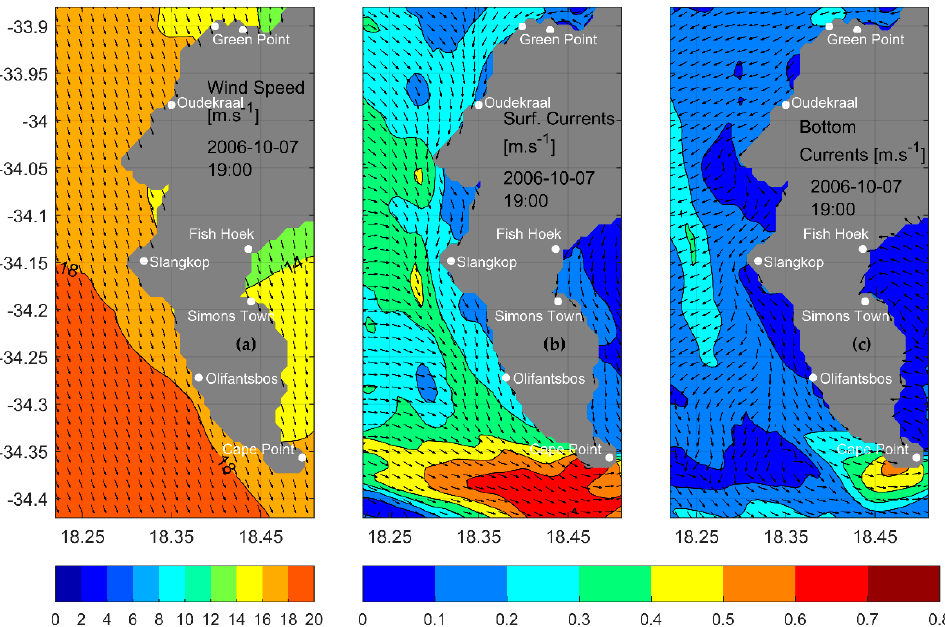
Figure 11. Near-surface ( b ) and bottom flows ( c ) near the Cape Peninsula under strong north-westerly wind conditions ( a